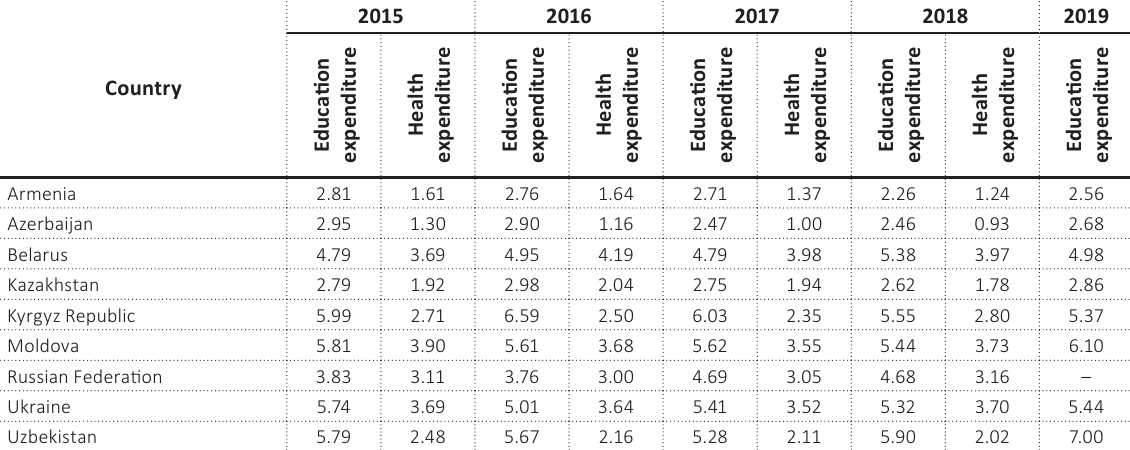
Table 4. Government expenditure on education, domestic general government health expenditure (% of